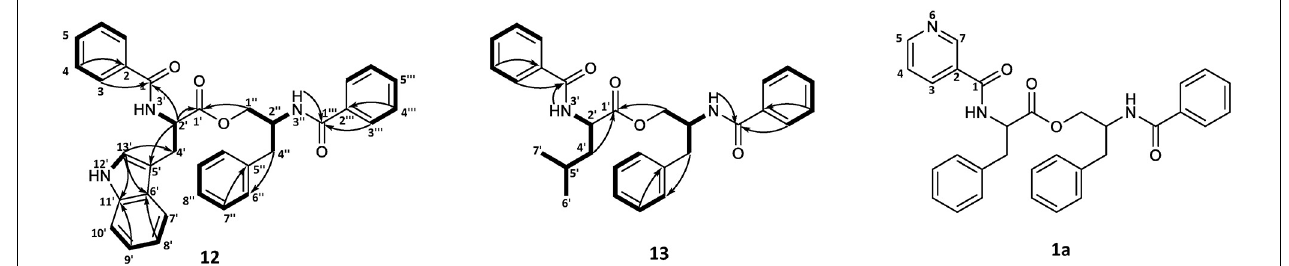
FIGURE 5 | COSY and key HMBC correlations for asperphenamates W ( 12 ) and L ( 13 ) and proposed structure for asperphenidine F1 ( 1a ).